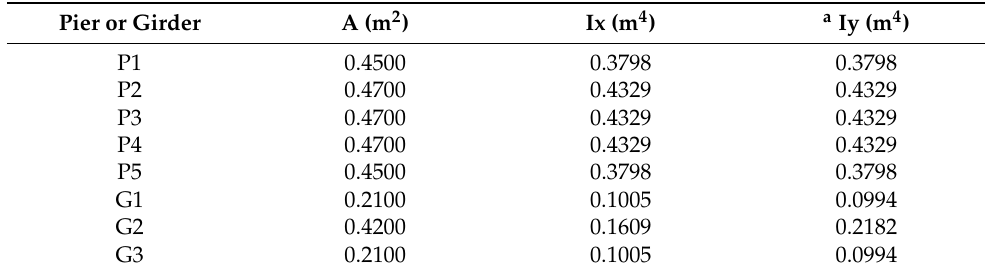
Table 1. Cross-sectional properties of girders and piers.